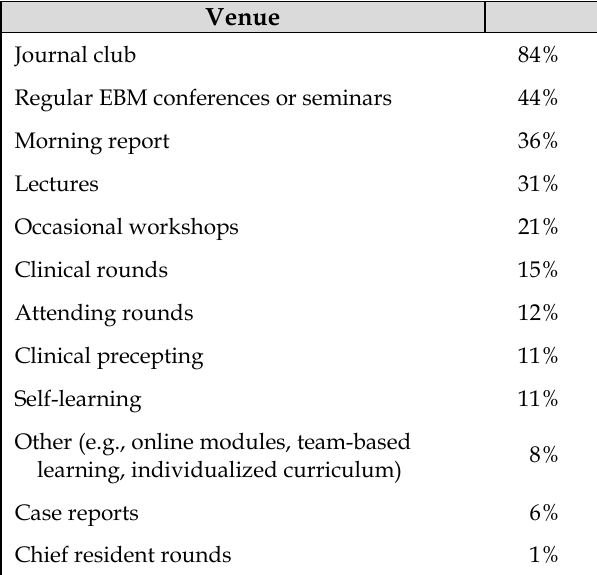
Table 3 Perception of most effective venues for